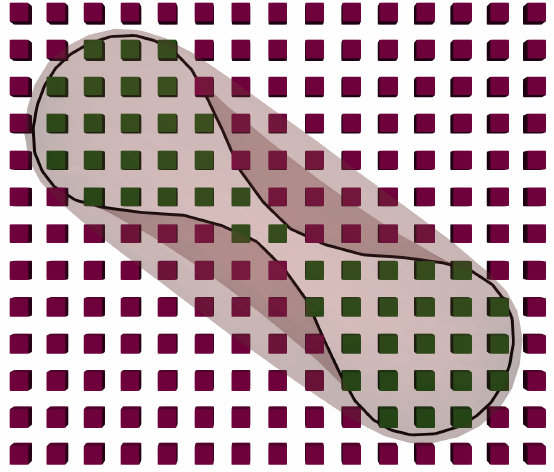
Figure 2. Visualisation of the lattice nodes in presence of an RBC. The relaxation parameters of the inner nodes are increased to represent the viscosity contrast. The green coloured nodes are those that are determined to be inside the RBC by our algorithm and are assigned τ int